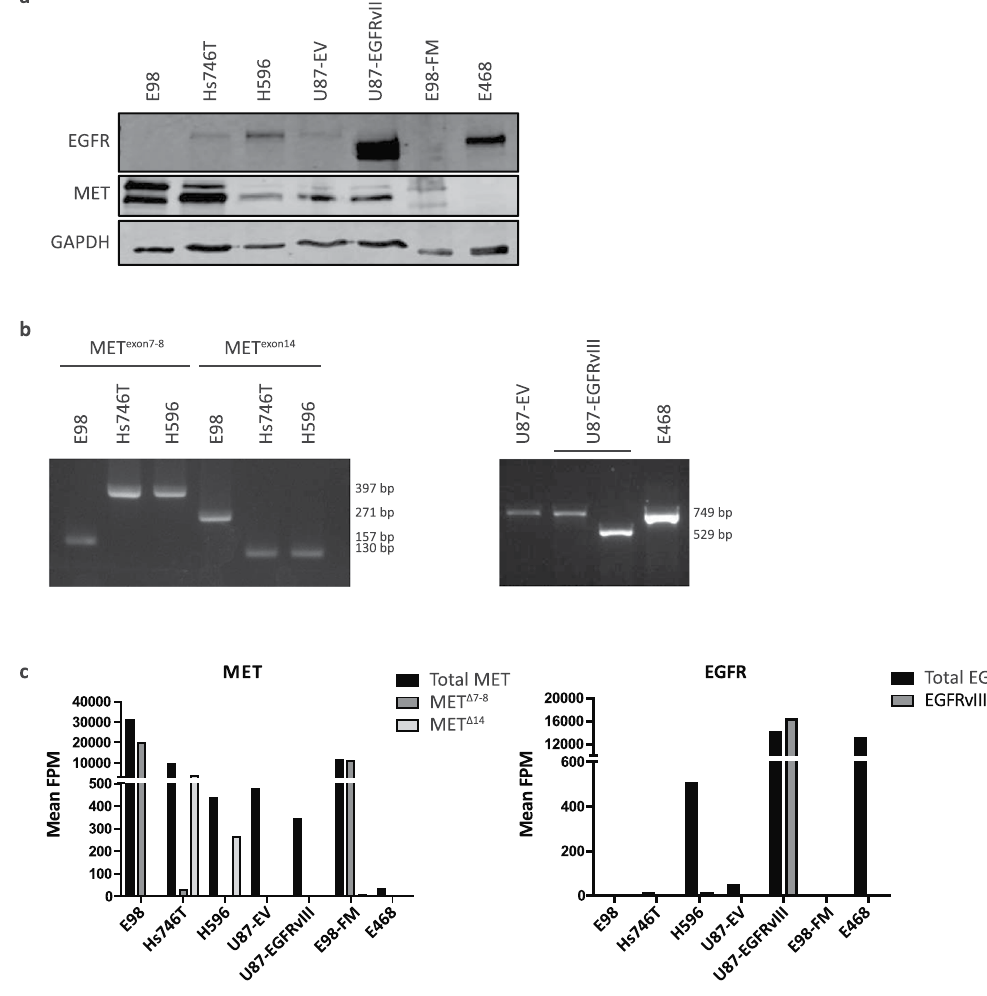
Figure 3. Expression levels and mutation status of MET and EGFR in relevant cell lines and xenografts. ( a ) western blot of cell lines E98, Hs746T and H596, U87-EV, U87-EGFRvIII, and xenografts E98-FM and E468, showing relative (total) MET and EGFR expression. Note that MET shows two proteins of different sizes, corresponding to the preform and the processed form of the protein 8 . ( b ) Left: MET PCR on cell lines E98, Hs746T and H596 to confirm MET Δ 7-8 and MET Δ 14 mutation status. Right: EGFR PCR on cell lines U87-EV and U87-EGFRvIII, and xenograft E468, to confirm EGFR wt and EGFRvIII status. ( c ) SmMIP targeted transcriptome profiling of MET (left) and EGFR (right) quantifies variant-specific expression levels in cell lines and xenografts. While E98 cells and xenografts express the MET Δ 7-8 variant, Hs746T and H596 predominantly express the MET Δ 14 variant. U87 cells express MET wt transcripts. EGFR wt transcript expression is present in Hs746T, H596, U87 and E468 cells and xenografts, while the EGFRvIII variant is only present in the U87- EGFRvIII cell